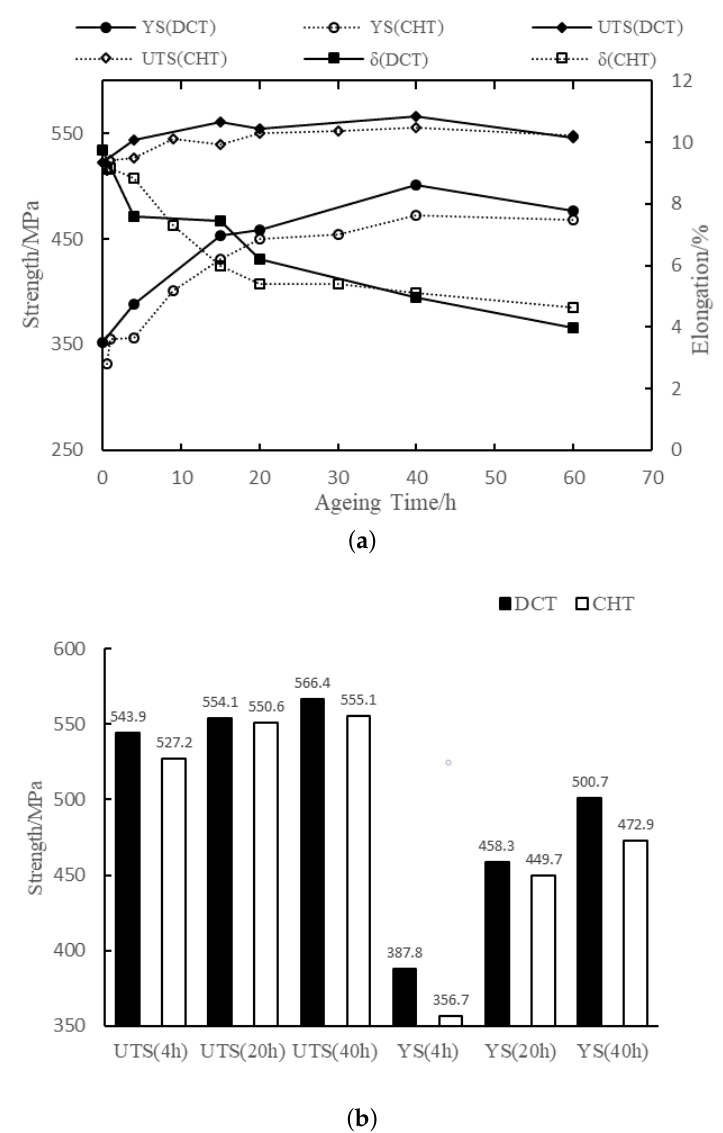
Figure 5. Comparison of ( a ) yield strength (YS, left y -axis) in engineering stress, ultimate tensile strength (UTS, left y -axis) in engineering stress and elongation ( δ , right y -axis) variations along the ageing time of SiCp–AA2009 composites under CHT and DCT strategies; ( b ) detailed UTS and YS values comparison under specific ageing